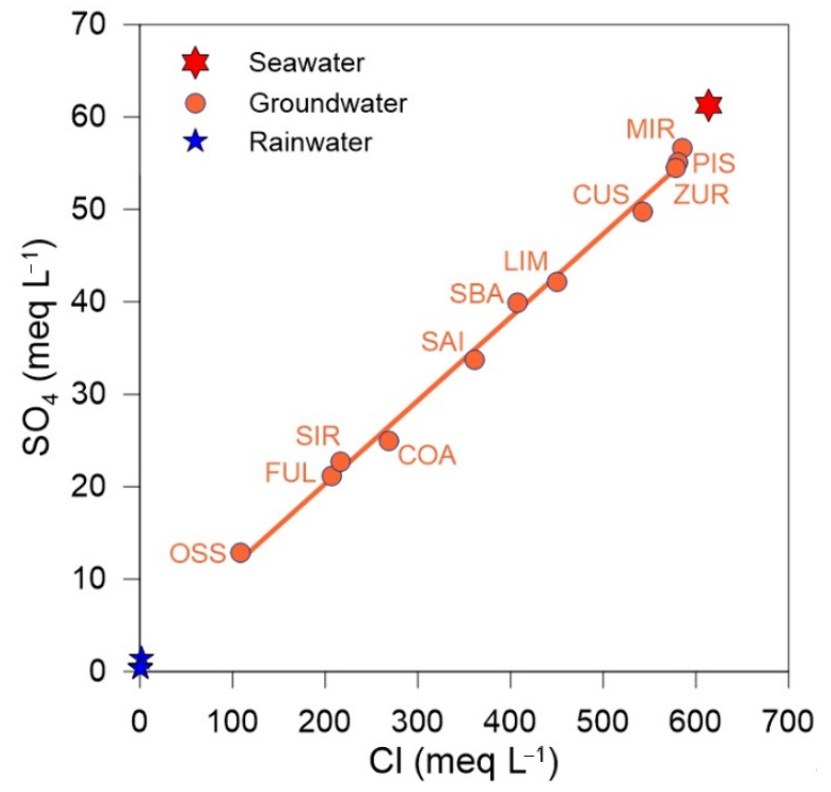
Figure 6. Cl vs. SO 4 diagram reporting the values for groundwater, rainwater (two sampling sites) [24], and seawater [11] of Stromboli Island.